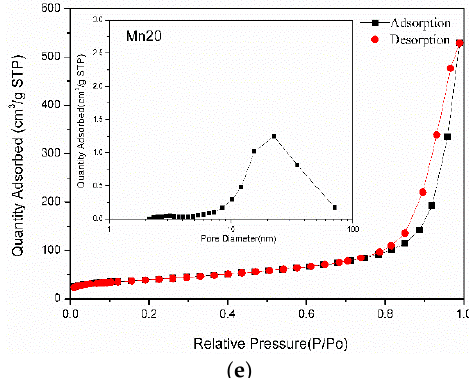
Figure 3. N 2 adsorption/desorption isotherms of Mn-doped MgAlO x mixed oxides. ( a ) Mn0; ( b ) Mn5; ( c ) Mn10; ( d ) Mn15; ( e ) Mn20. Table 2. Textural properties of the oxide catalysts .